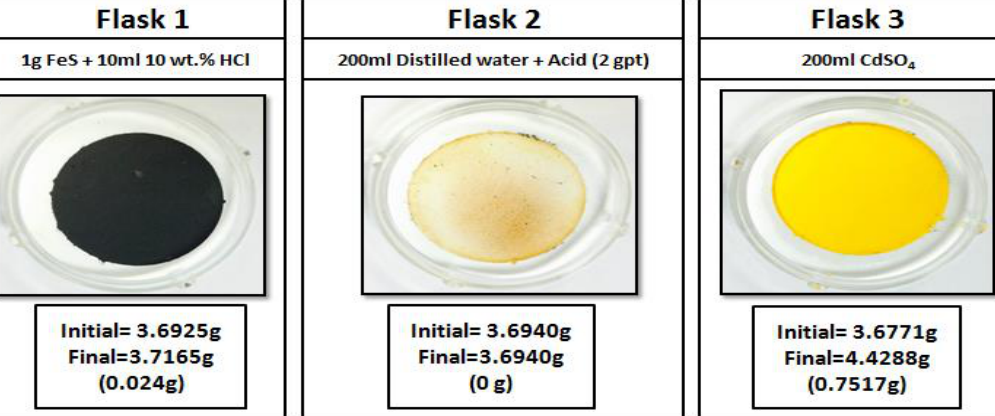
Figure 19. Bromate gel breaker interactions in a sour environment for 4 h at 77 °F. Figure 20. Persulfate gel breaker interactions in a sour environment for 4 h at 77 °F. H 2 S can form a variety of species such as sulfate, sulfite, thiosulfate, and elemental sulfur in the presence of oxidants [68–71]. The precipitation previously seen in flasks 2 were later analyzed using the ESEM/EDS. The results of the ESEM/EDS showed elemental sulfur as the main precipitation, Figure 21. This is due to the oxidizer’s reaction with H 2 S that produces insoluble elemental sulfur, as seen in Equation (1). The amount of sulfur was higher when persulfate gel breakers were used compared to bromate gel breakers.